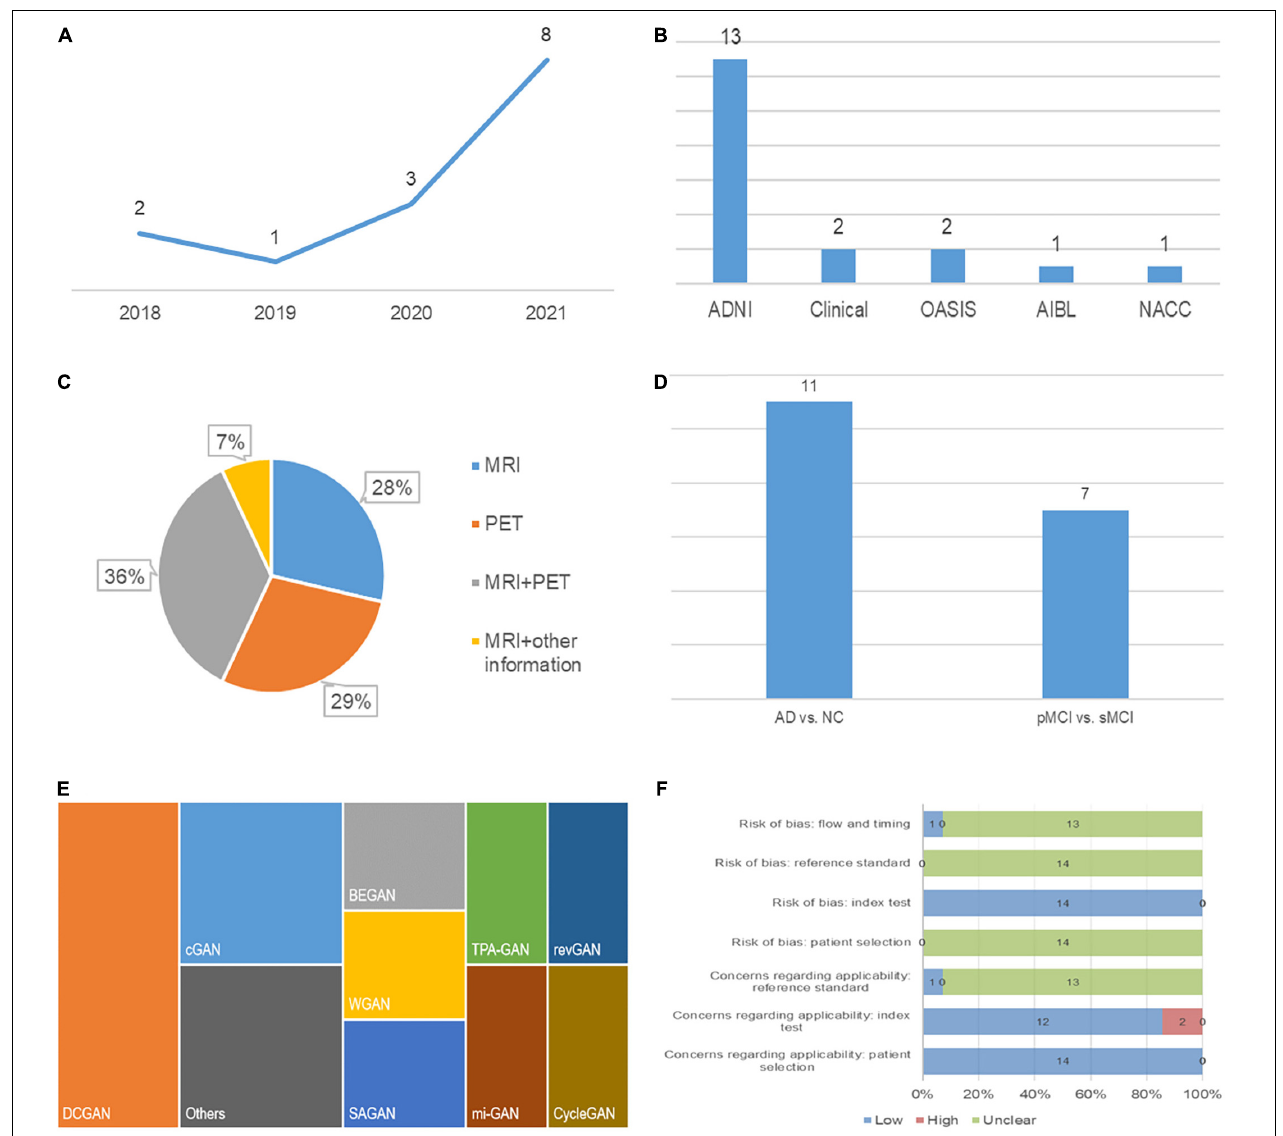
FIGURE 2 | Characteristics of the included studies: (A) Publication year, (B) data source, (C) modality of data, (D) classification task, (E) type of GAN, and (F) quality